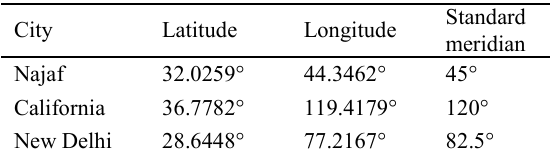
Table 3. Variable input